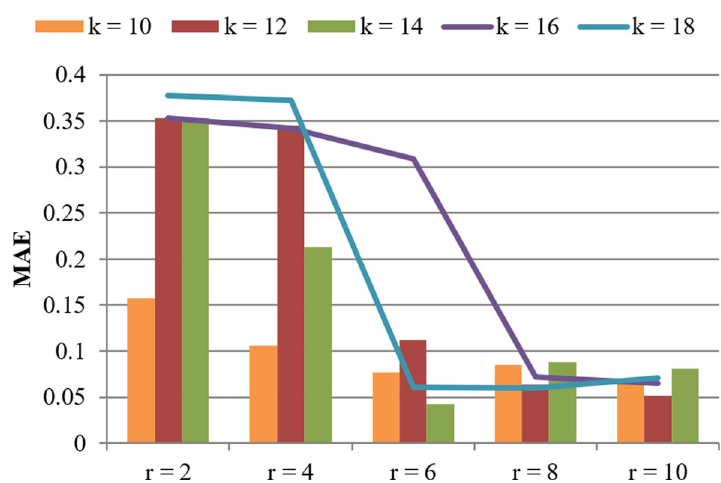
Fig. 7 Accuracy of our algorithm (w.r.t. r and k